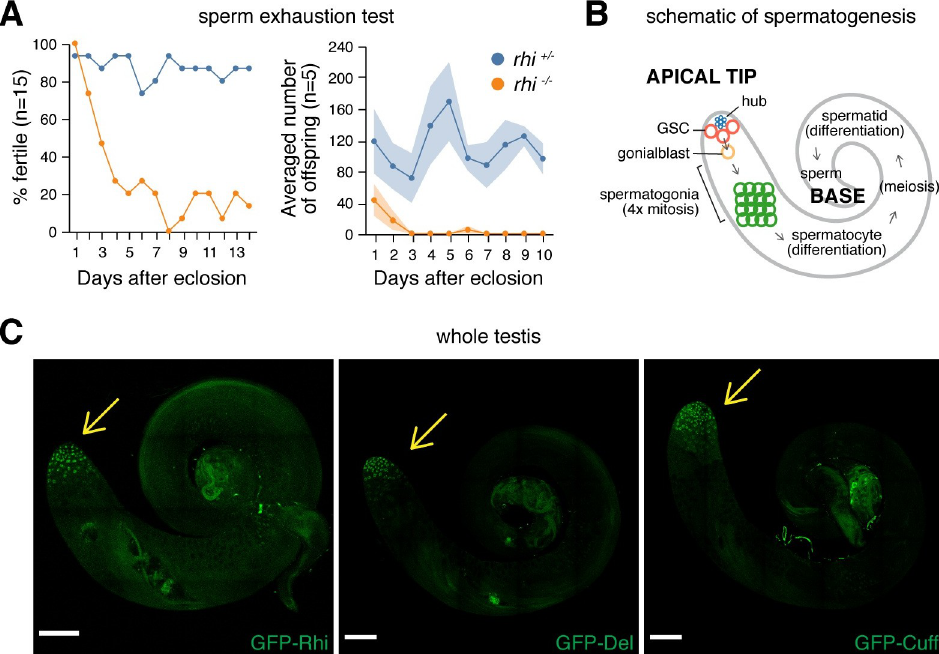
charts report results from two independent sperm exhaustion tests. (B) A schematic of spermatogenesis, showing major developmental stages of male germline as well as the somatic hub that serves as germline stem cell (GSC) niche. (C) Expression of GFP-tagged Rhi (left), Del (middle) and Cuff (right) transgenes driven by their respective regulatory regions. Expression of all three proteins can only be seen at the apical tip of testis (pointed to by the yellow arrow). Scale bar: 100 μ